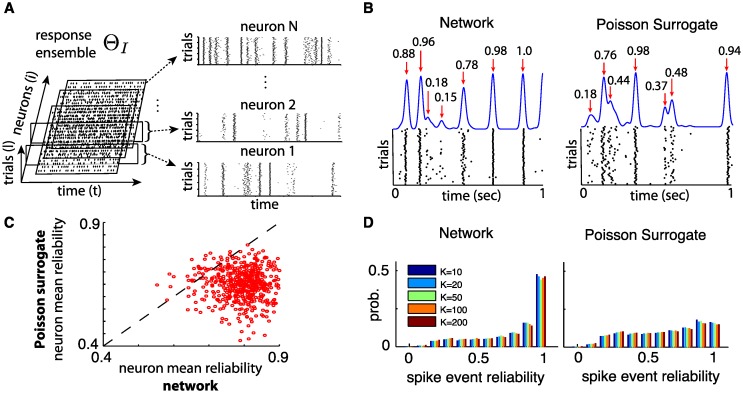
(A) Spike patterns from a response ensemble, ΘI, containing network responses to input I(t) on many trials. (B) Single neuron spike response examples across 50 trials. Left: from a randomly chosen neuron in the network. Right: same neuron as right but replacing network interactions by Poisson spike surrogates following MF assumptions (see text for details). Bottom row shows spike raster plots and top row shows corresponding Gaussian-filtered PSTH (σ = 10 ms). Red arrows indicate spike events and numbers indicate spike event reliability. See text for details about calculation of reliability. (C) Scatter plot showing the mean reliability of each neuron in a network (N = 500, K = 20) against its counterpart in the Poisson surrogate inputs paradigm. Neuron mean reliability is the average reliability of all spike events produced by the neuron. (D) Left: Histogram of spike event reliability sampled over all spike events produced by networks with different values of K (N = 2000). Right: Same as left for Poisson surrogate inputs paradigm. For (C) and (D), quantities sampled from simulations lasting 100 seconds over 100 trials.